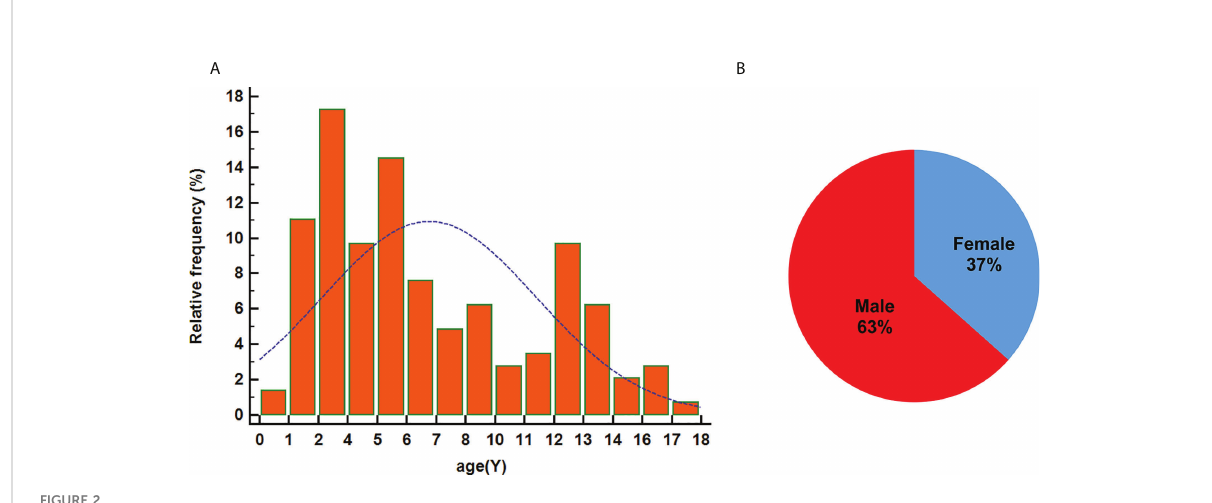
FIGURE 2 Age at diagnosis (A) and sex distribution (B)